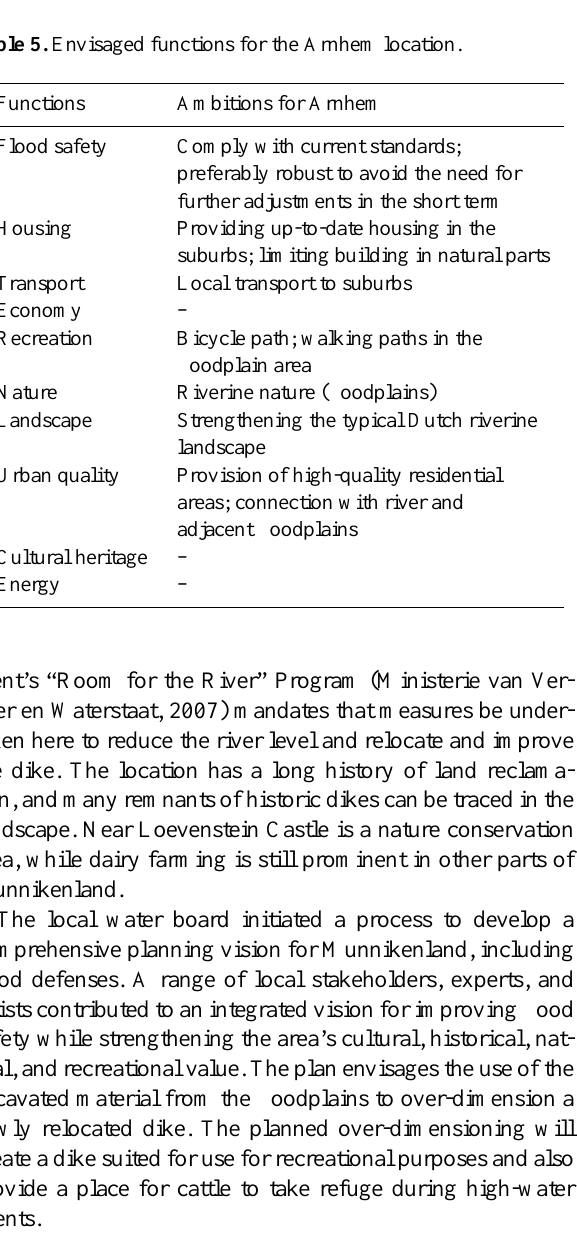
Table 4. Envisaged functions for the Marsdijk location.